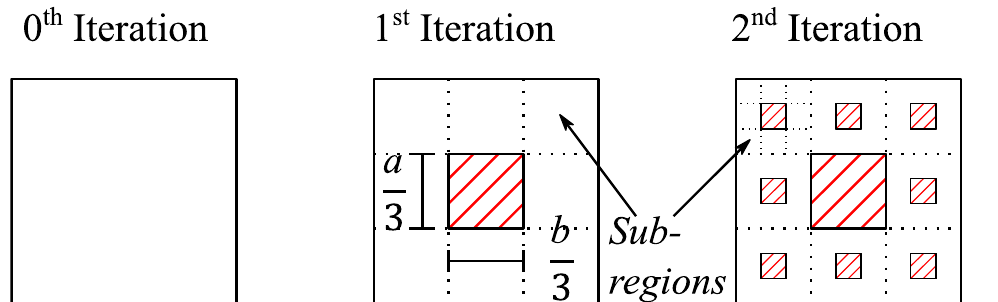
Figure 6. Construction principle of the menger sponge fractal. The zeroth iteration corresponds to the original surface without any modifications. In the first iteration, a slab of material is removed in the center of the face. The cross section of this slab corresponds to one third of side lengths of the rectangle. In the second iteration, the surface of the rectangle is subdivided into nine smaller surfaces with side lengths a /3 and b /3. For each of those smaller surfaces, the process of the first iteration is repeated, such that a slab of material with cross section a /9 and b /9 is removed.